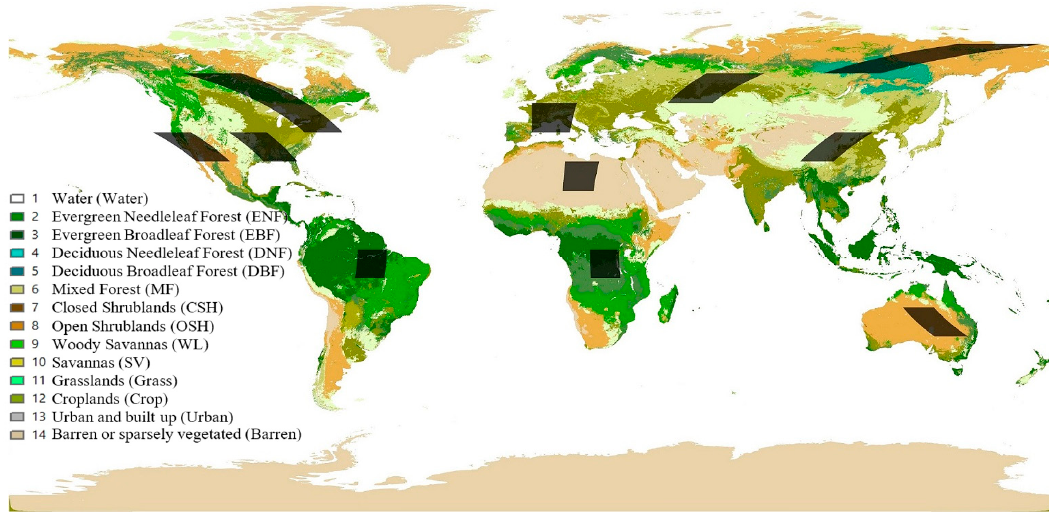
Figure 2. 2001 Land Cover (MCD12C1) with shaded squares showing the selected FPAR / LAI tiles used in this study.